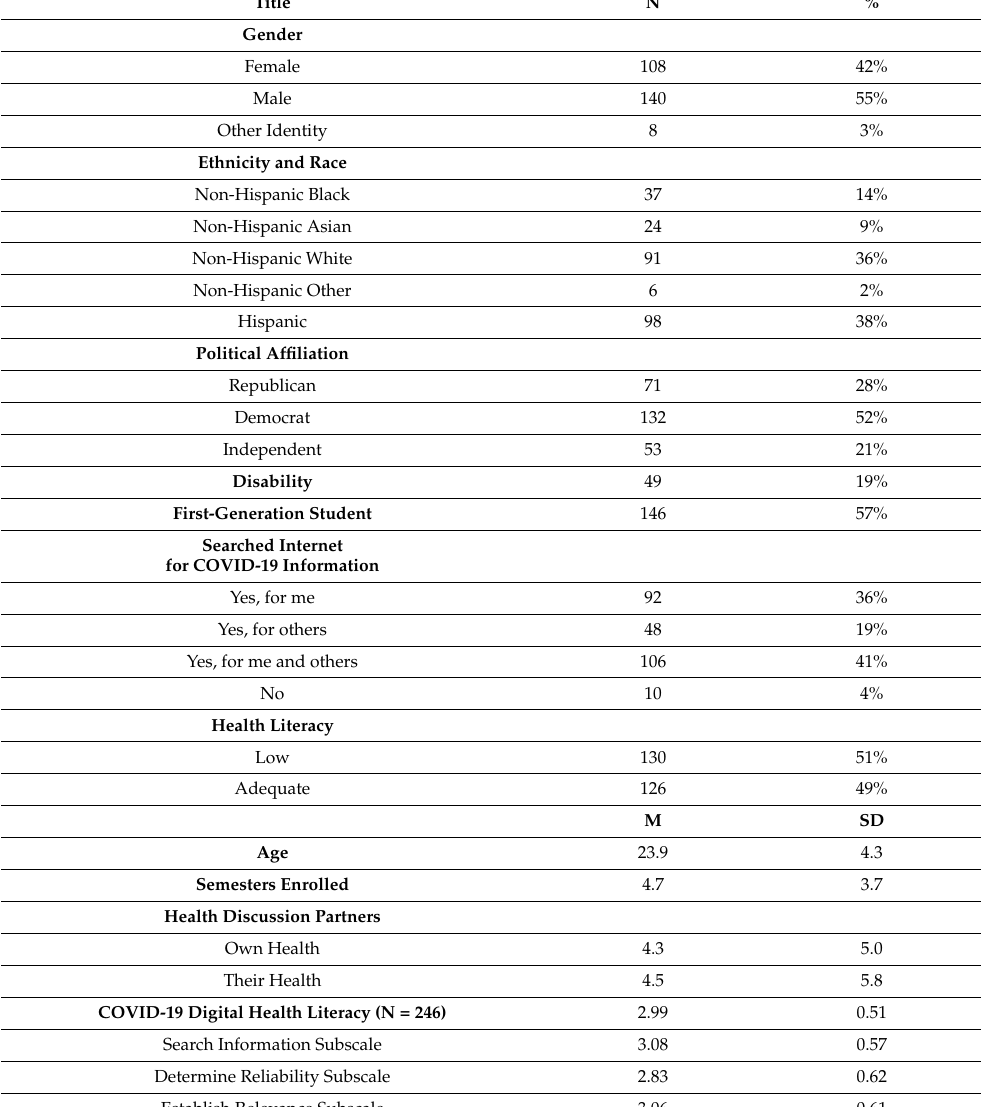
Table 1. General sample characteristics (N =